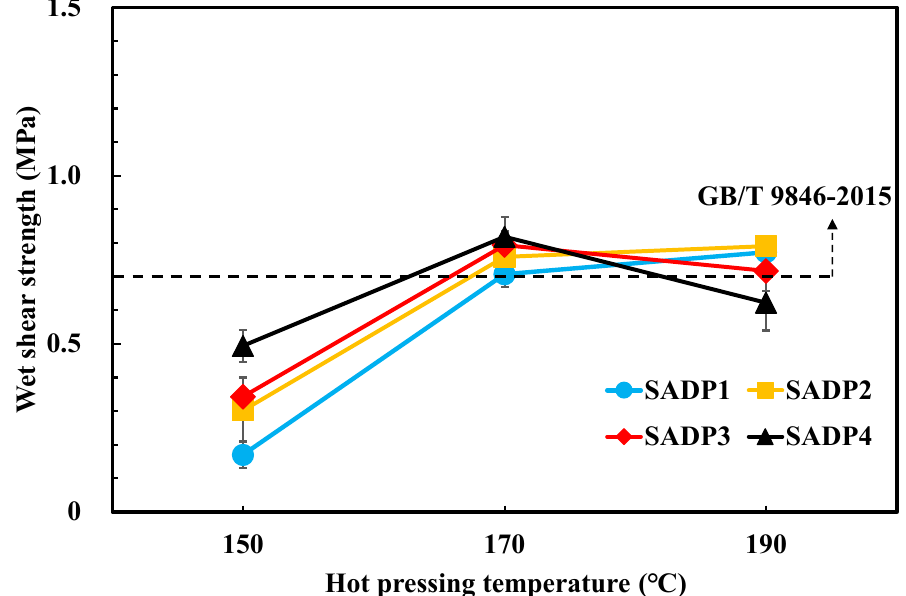
Figure 4. Wet shear strength of the plywood bonded with SADP adhesives. Table 3. Wood failure of the three ‐ ply plywood bonded with SADP adhesives at different hot pressing temperatures.